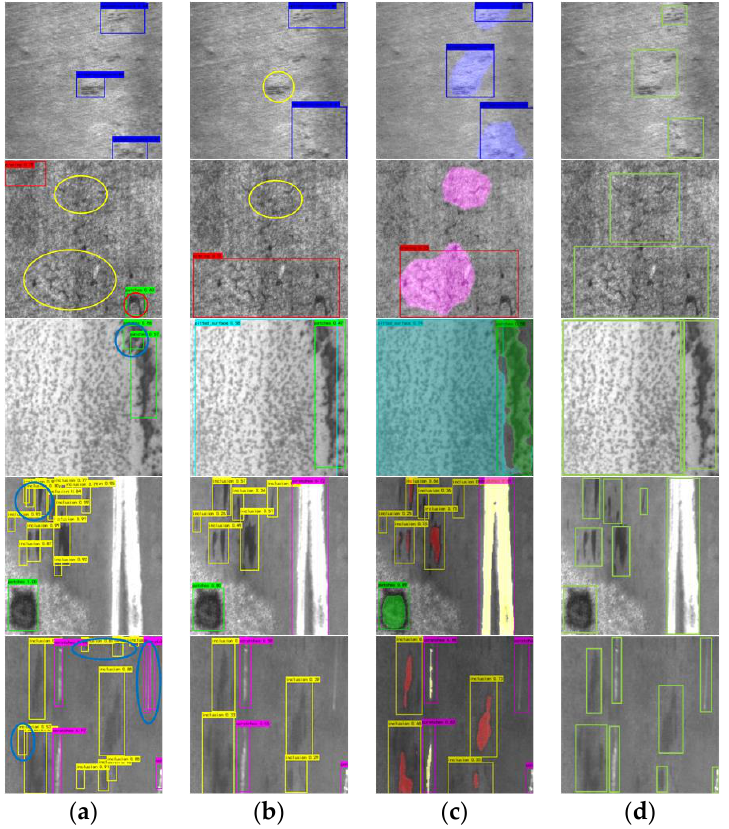
Figure 6. Comparison of detection results. ( a ) Faster-RCNN. ( b ) yolov5s. ( c ) Ours. ( d ) Ground truth. The colored circles in the figure show false detections.